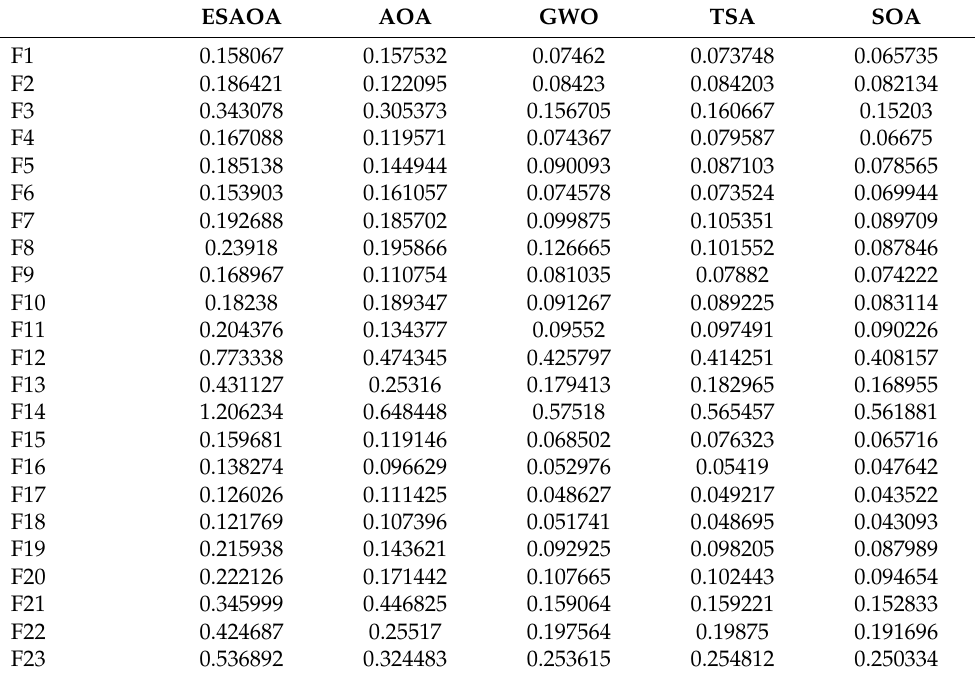
Table 5. CPU time (s) of five techniques on 23 benchmark